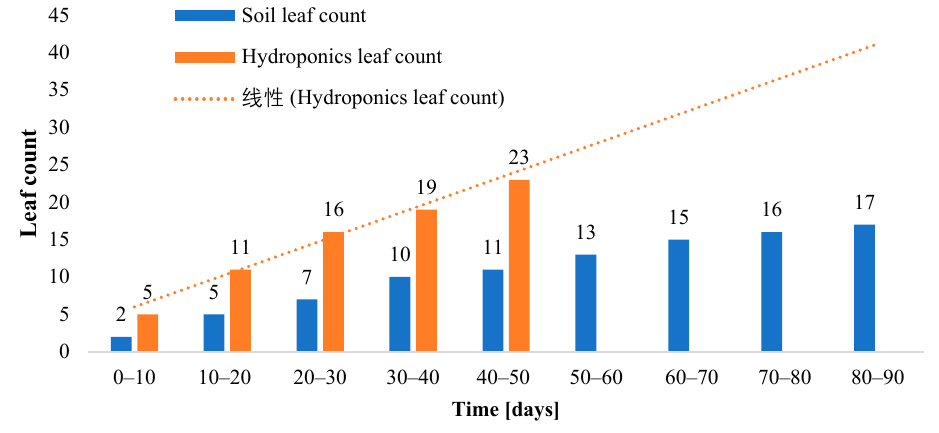
Figure 17. Comparison of romaine lettuce leaf count grown in soil and the NFT hydroponic setup.